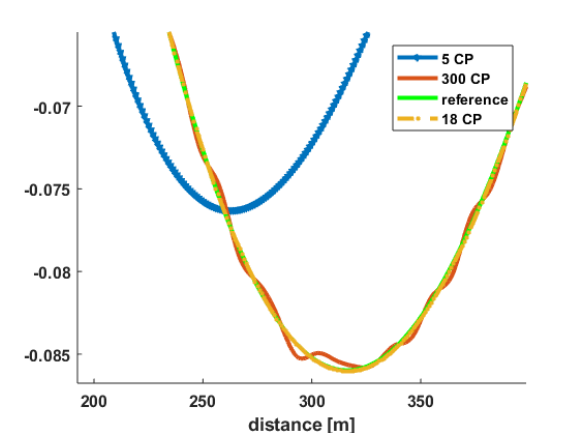
Fig. 2. Impact of an approximated determination of the number of CP. The green reference curve represents a known B-spline curve to which white noise, having a variance of 1mm 2 , was added. The blue curve corresponds to an underfitting of the simulated observations, whereas the red one is an overfitting, i.e. too many CP, the noise being fitted instead of the curve.